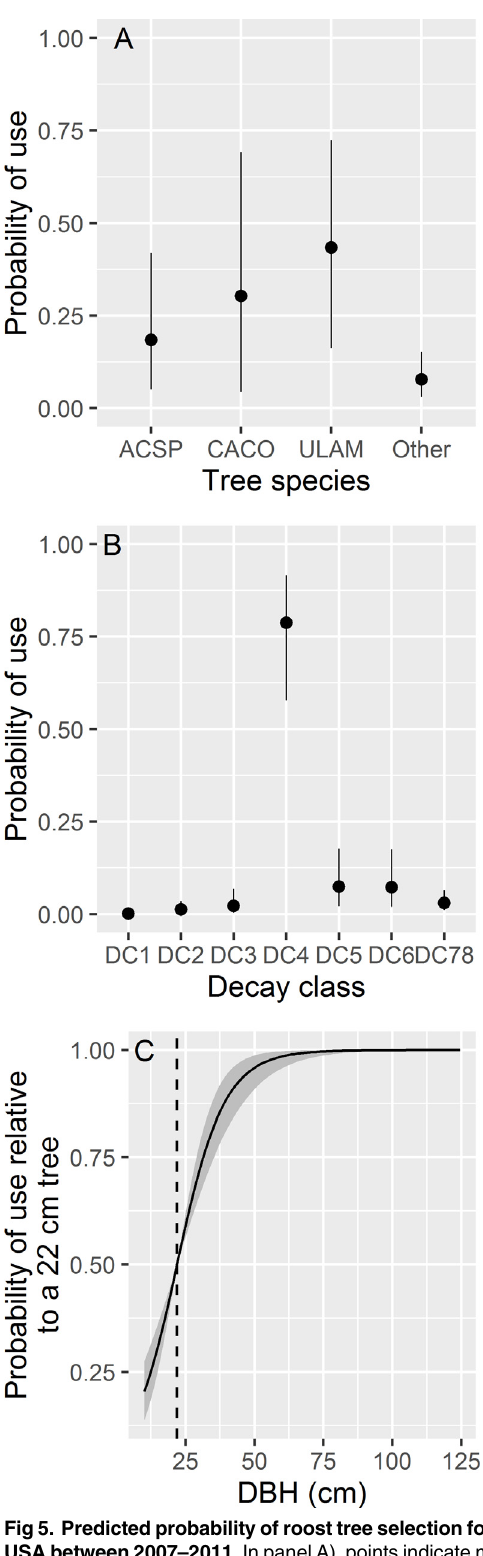
Fig 5. Predicted probability of roost tree selection for Indiana bats ( Myotis sodalis ) in Fort Drum, NY, USA between 2007 – 2011. In panel A), points indicate mean posterior probability of use and vertical lines represent the limits of 95% credible intervals. This panel assumes bats are faced with a choice of 4